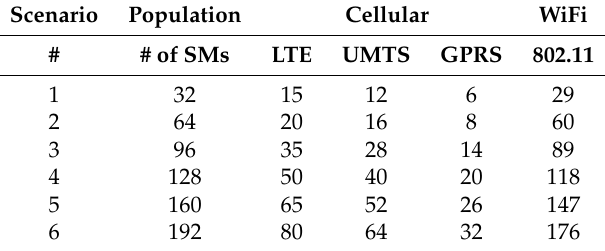
Table 4. Energy consumption: cellular and WiFi